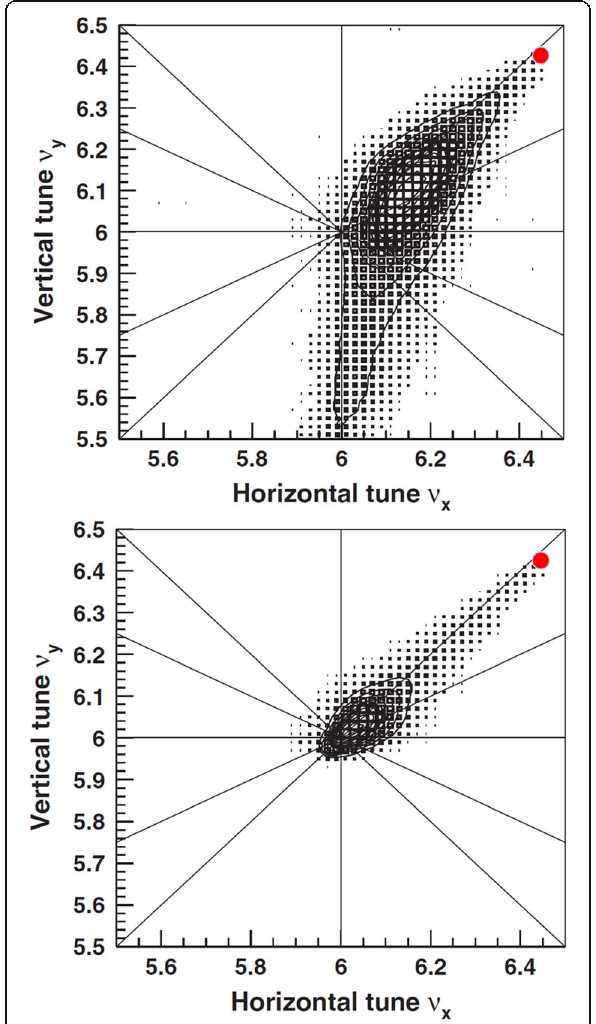
Fig. 19 Simulation results for the J-PARC RCS; space charge tune shifts at the end of injection obtained without (upper) and with (lower) phase-space painting, where the red circles show the bare betatron tunes defined by the external focusing fields and the solid lines represent the systematic betatron resonances up to fourth order